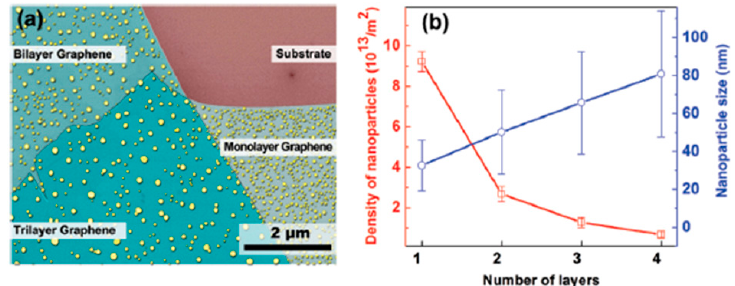
Figure 25. Morphologies, size, and density of Au nanoparticles on n-layer graphenes after annealing at 1260 ◦ C in vacuum for 30 s (false-color image). Note that no Au NPs are found in the substrate. ( a ) Au NPs on monolayer, bilayer, and trilayer graphene, respectively; ( b ) Statistics of the size and density of gold nanoparticles on n-layer graphenes. Reproduced from Reference [69] with permission from the American Chemical Society.